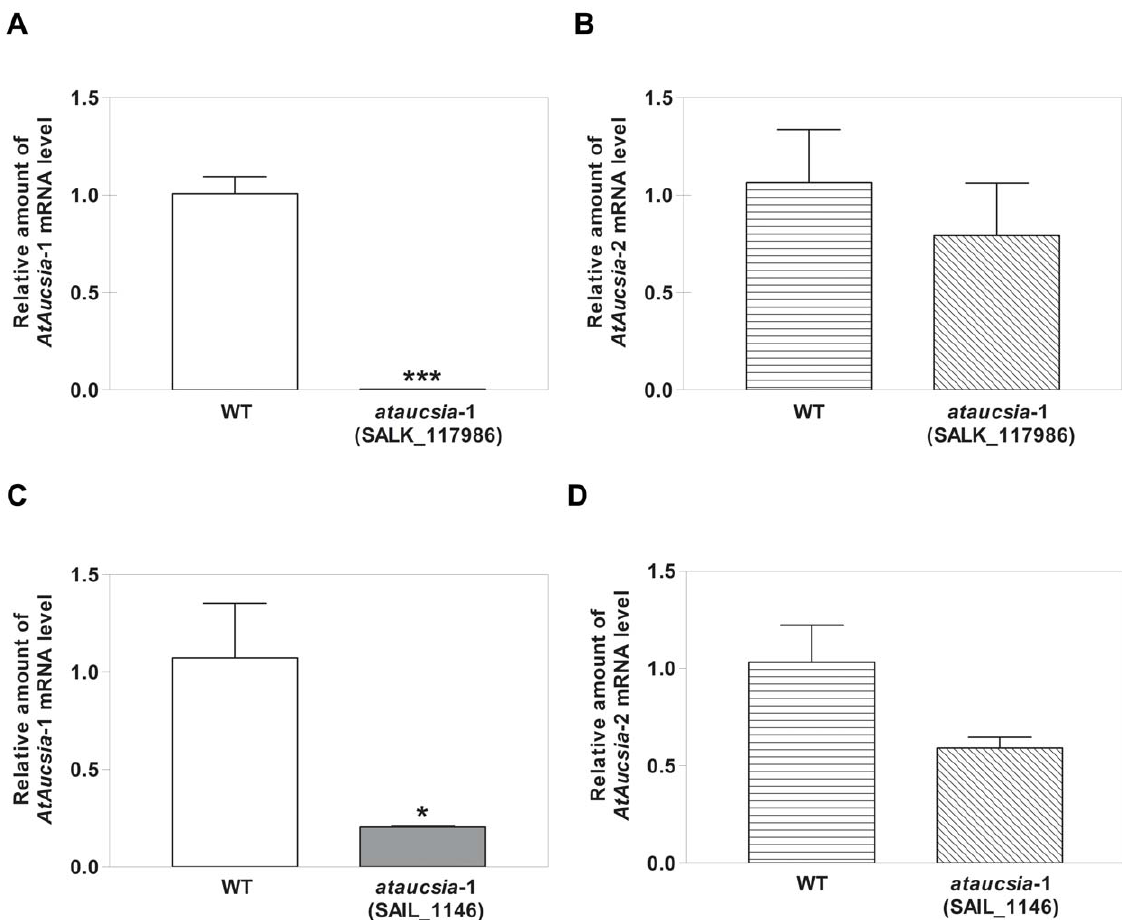
Figure 2. Aucsia gene expressions in ataucsia -1 mutants. (A) and (C) AtAucsia -1 mRNA level in ataucsia -1 mutants SALK_117986 and SAIL_1146, respectively. The relative mRNA level of AtAucsia -1 was assessed by qRT-PCR in comparison to the level of AtAucsia -1 in wild-type plants. (B) and (D) AtAucsia -2 mRNA level in ataucsia -1 mutants SALK_117986 and SAIL_1146, respectively. The relative mRNA levels of AtAucsia -2 was evaluated by qRT- PCR and compared with the level of AtAucsia -2 in wild-type plants. The values reported are means 6 standard error (SE) (n=3). Student’s t -test was applied. *P , 0.05; ***P , 0.001 versus wild-type.